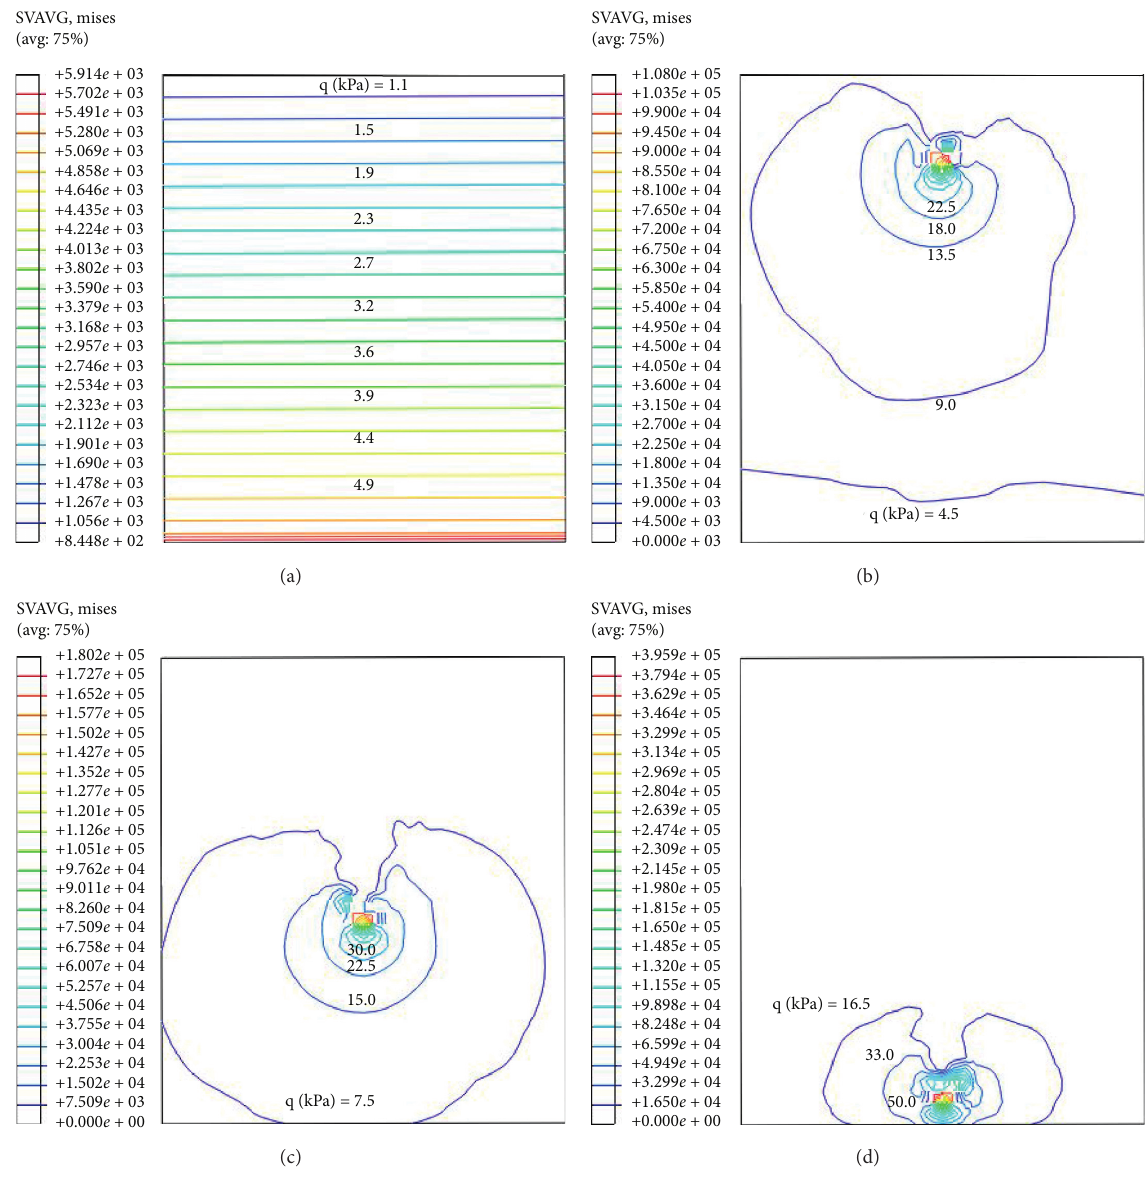
Figure 5: Mises stress contours for different drilling depths. (a) z � 0. (b) z � L/ 3. (c) z � 2L/ 3. (d) z � L